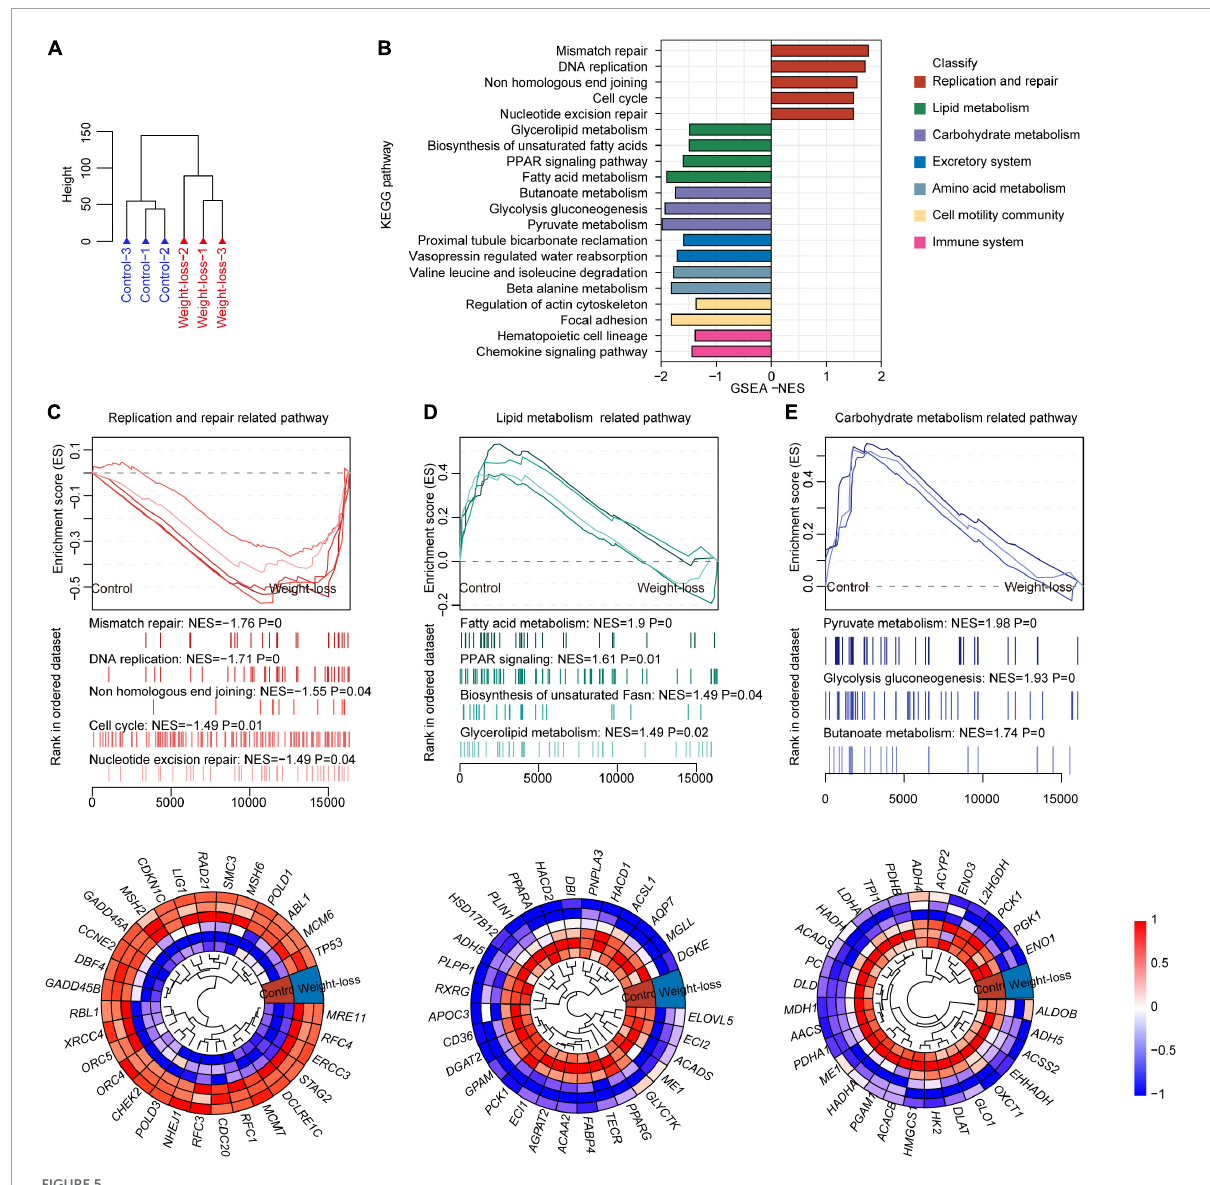
FIGURE5 The metabolic signature of visceral adipose tissue in a weight-loss diet in beagles. (A) Total RNA was extracted from visceral adipose tissues of control diet and weight-loss diet beagles after 8 weeks of feeding and then subjected to RNA-seq. Cluster images show the distribution of samples from control diet and weight-loss diet beagles according to gene expression patterns in RNA-seq. n = 3 beagles/group. (B) Gene set enrichment analysis (GSEA) was carried out between the control diet and weight-loss diet beagles. GSEA showing the enriched pathways related to lipid metabolism based on the RNA-seq dataset in control diet and weight-loss diet beagles after 8 weeks of feeding. (C) Representative GSEA enrichment score curves of the replication and repair-related pathways. Genes on the far left correlated the most with control diet samples, and genes on the far right correlated the most with weight-loss diet samples. A representative heatmap of the leading genes is shown below the curve. (D) Representative GSEA enrichment score curves and heatmap of the lipid metabolism-related pathways and corresponding leading genes. (E) Representative GSEA enrichment score curves and heatmap of the carbohydrate metabolism-related pathways and corresponding leading genes.